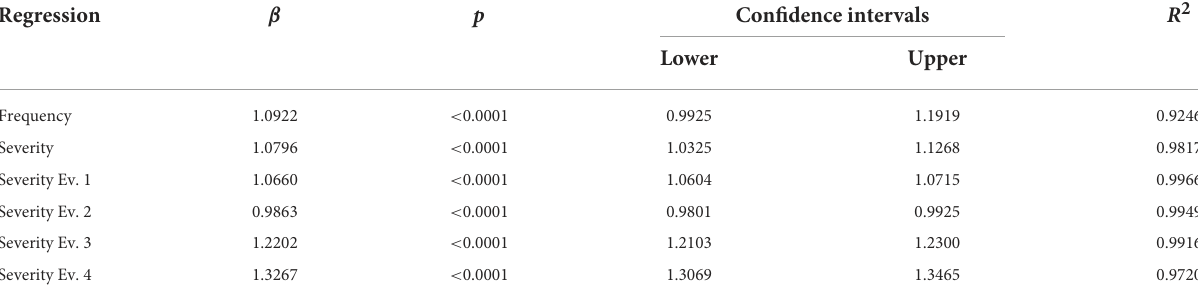
TABLE 6 Frequency and severity